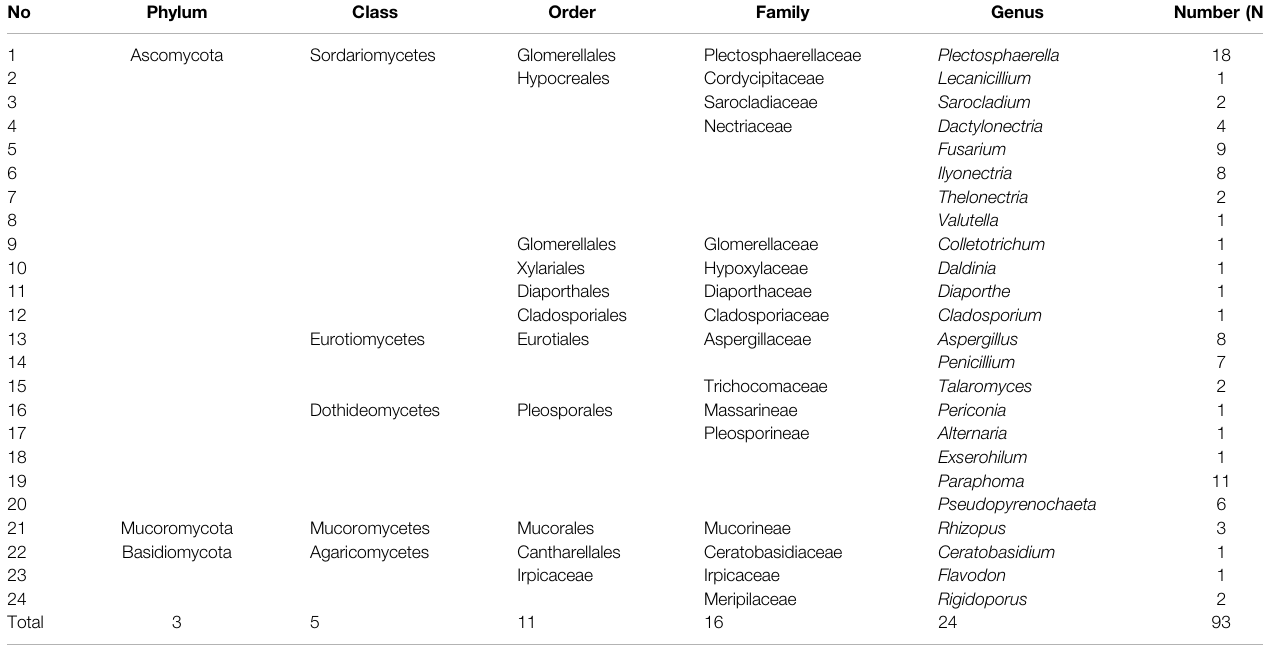
TABLE 2 | Taxa of all endophytic fungi isolates from P. bipinnati fi dus .